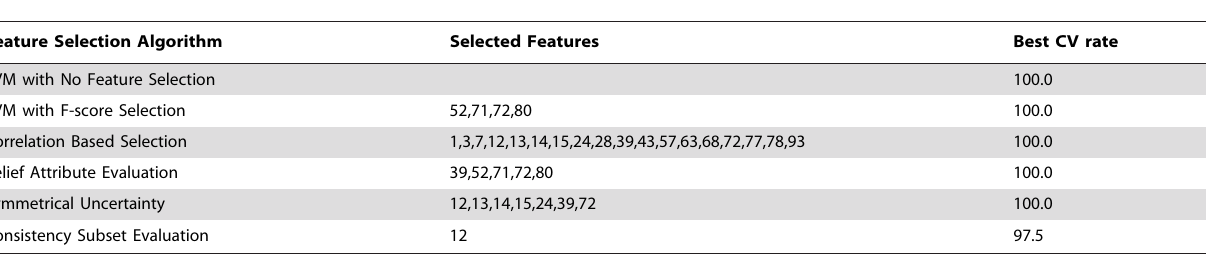
Table 5. Epithelial vs Mesenchymal comparison in control tissue samples.